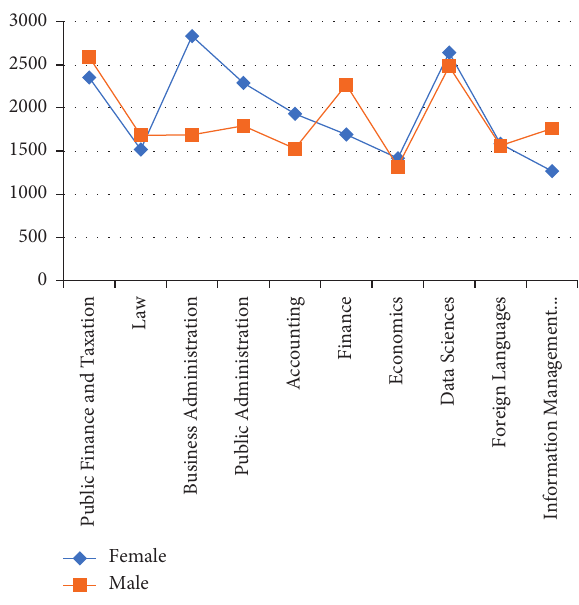
Figure 2: Average of total teaching work of male and female teachers of each